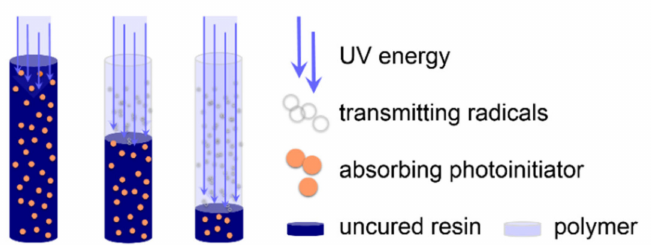
Figure 1. Schematic representation of a frontal photopolymerization reaction [23]. Penetration depth of light increases with radical formation, i.e., bleaching of the photoinitiator. Accordingly, a polymerization front propagates through the